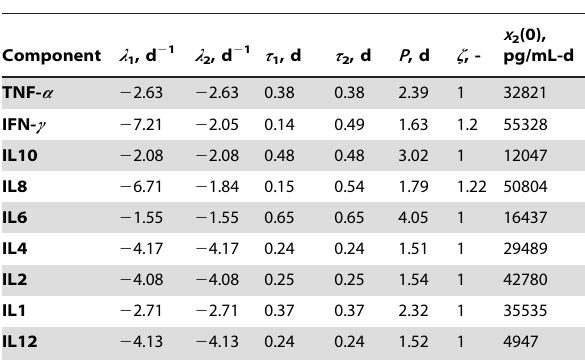
Table 1. Eigenvalues, Time Constants, Periods, Damping Ratios, and Initial Rates of Change for Uncoupled, Second- Order Cytokine Models.